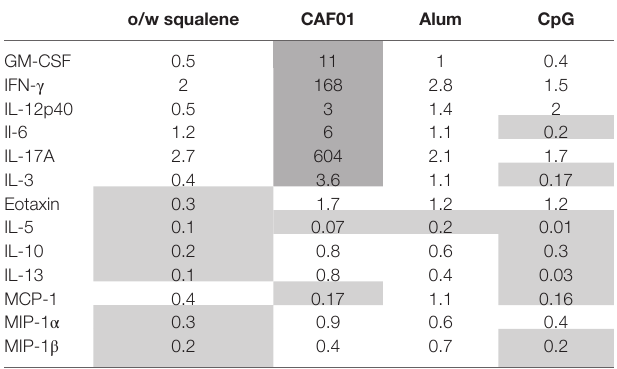
TaBle 1 | ratio of cytokine or chemokine production between formulations including adjuvants and antigen